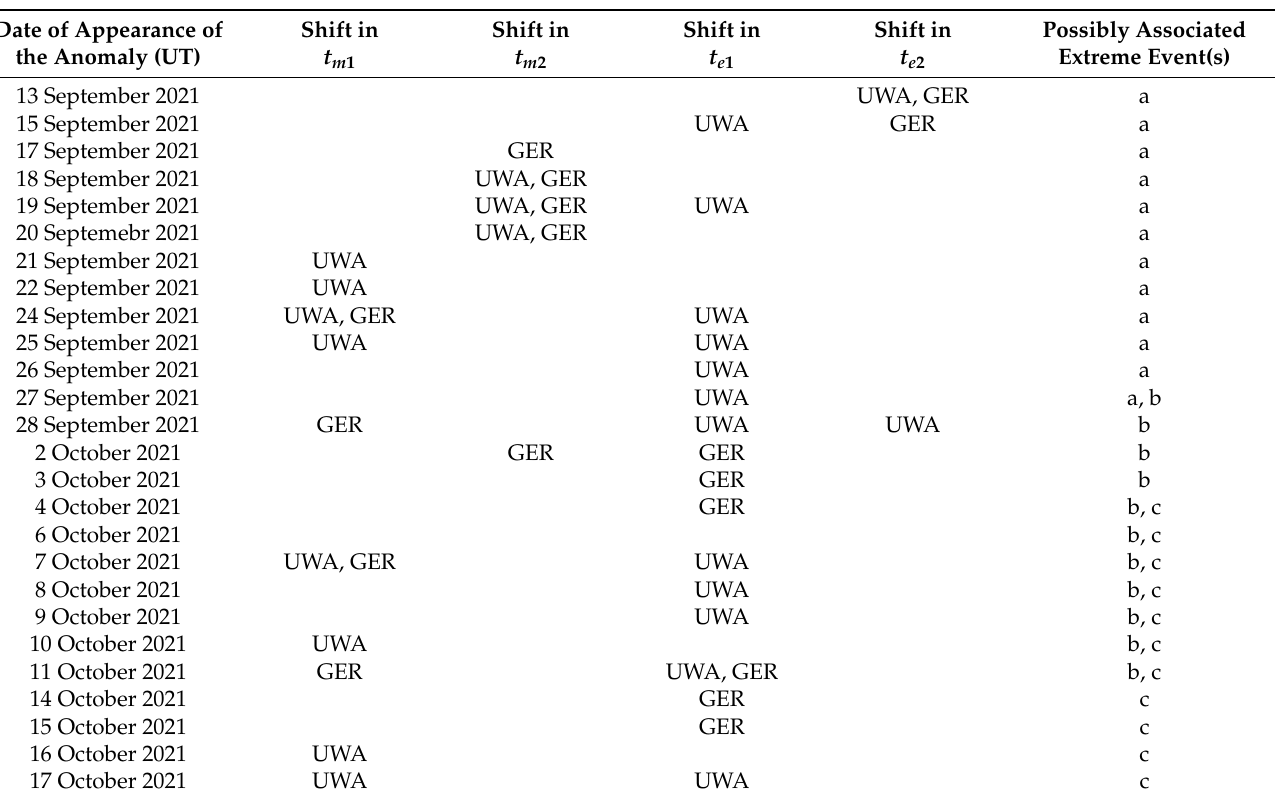
Table 5. Results from diurnal sequential plots for 2021 Crete EQs. UWA and GER denote the station where the corresponding anomaly in TTs has been